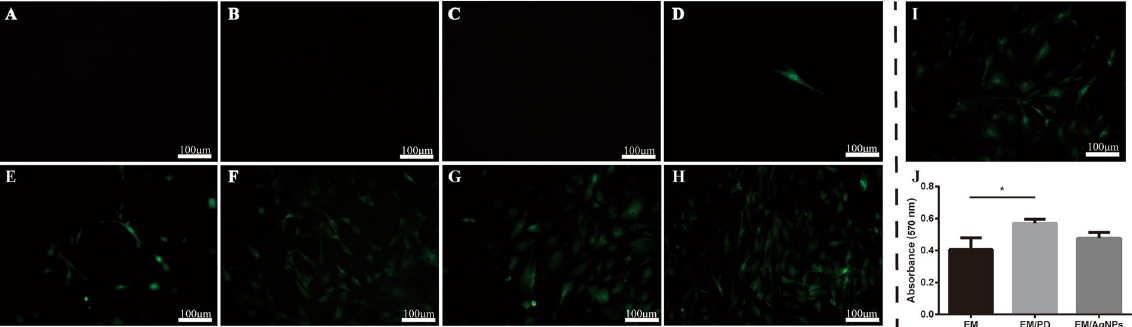
Figure 2. Cytotoxicity assessment of the optimized EM/AgNPs nanocomposite. Fluorescence microscopy images of GFP transgenic fibroblast attachment on the EM/PD films immersed in AgNO 3 solutions of different concentrations: ( A ) 50 mM; ( B ) 10 mM; ( C ) 1 mM; ( D ) 100 μ M; ( E ) 50 μ M; ( F ) 30 μ M; ( G ) 10 μ M; and ( H ) 0 μ M and ( I ) on EM. ( J ) Viability of fibroblasts cultured on EM, EM/PD and EM/AgNPs. The values are shown as the mean ± SD (n = 3).